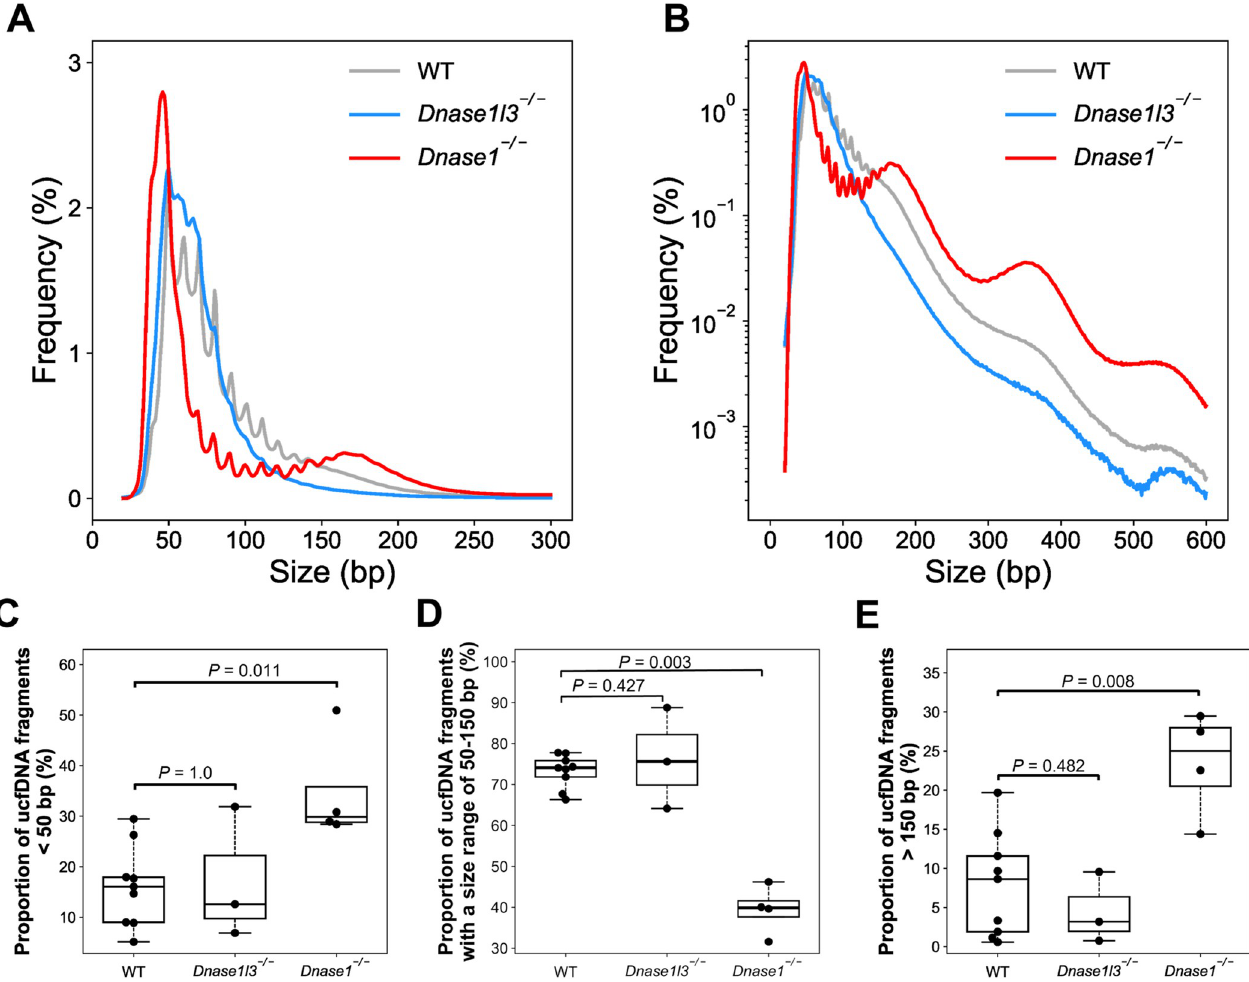
Fig 3. Size distributions of ucfDNA molecules. Size distribution plotted on a linear scale (A), on a logarithmic scale (B) of the y-axis. The grey, blue and red lines represent the median size profile of ucfDNA in WT (n = 9), Dnase1l3 -/- (n = 3), and Dnase1 -/- (n = 4) mice, respectively. Boxplots showing the proportion of the fragments < 50 bp (C), ranging from 50 to 150 bp (D), and > 150 bp (E).